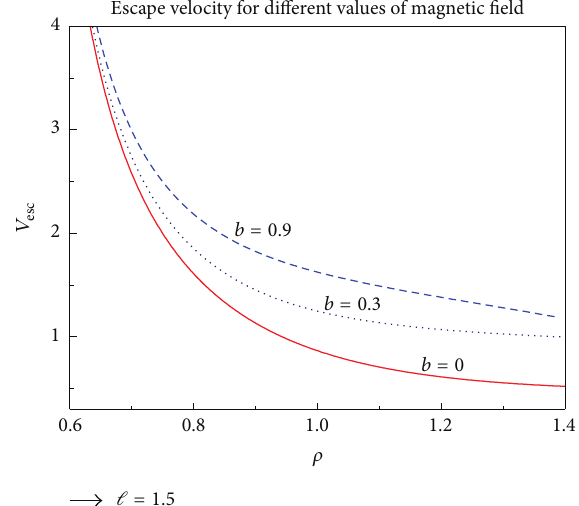
Figure 13: Trajectory of the escaping particle around RN-BH, for 𝑏 = 1 , ℓ = 1 , E = 1 , 𝜌[0] = 1.2 .